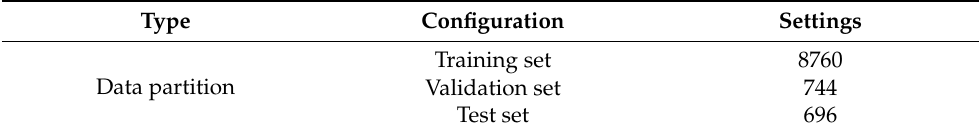
Table 5. Partitions of the input dataset of RNN-LSTM.